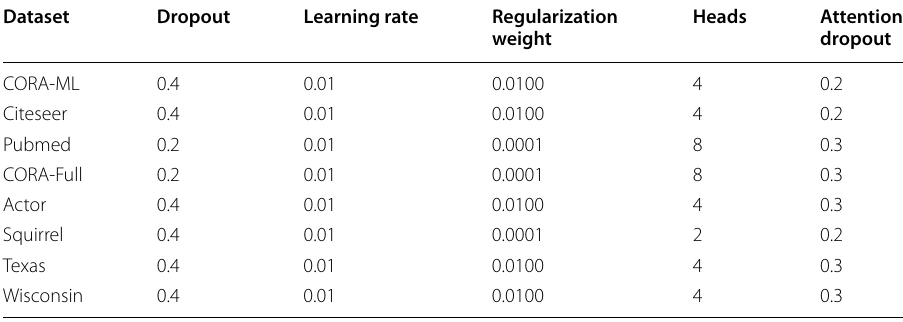
Table 4 Chosen hyperparameters for GAT model